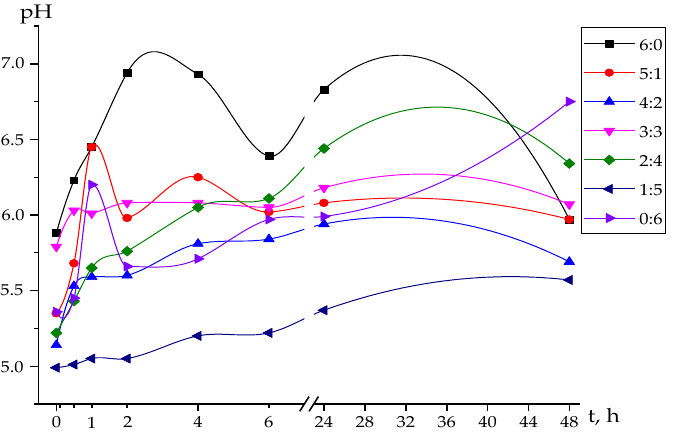
Figure 6. Changes in pH of a solution during the activation process as a function of time.